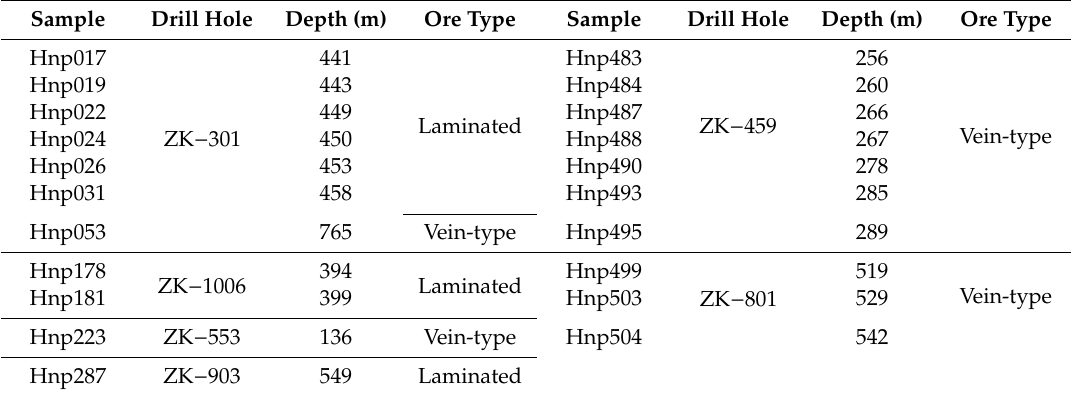
Table 1. Locations of samples used in this